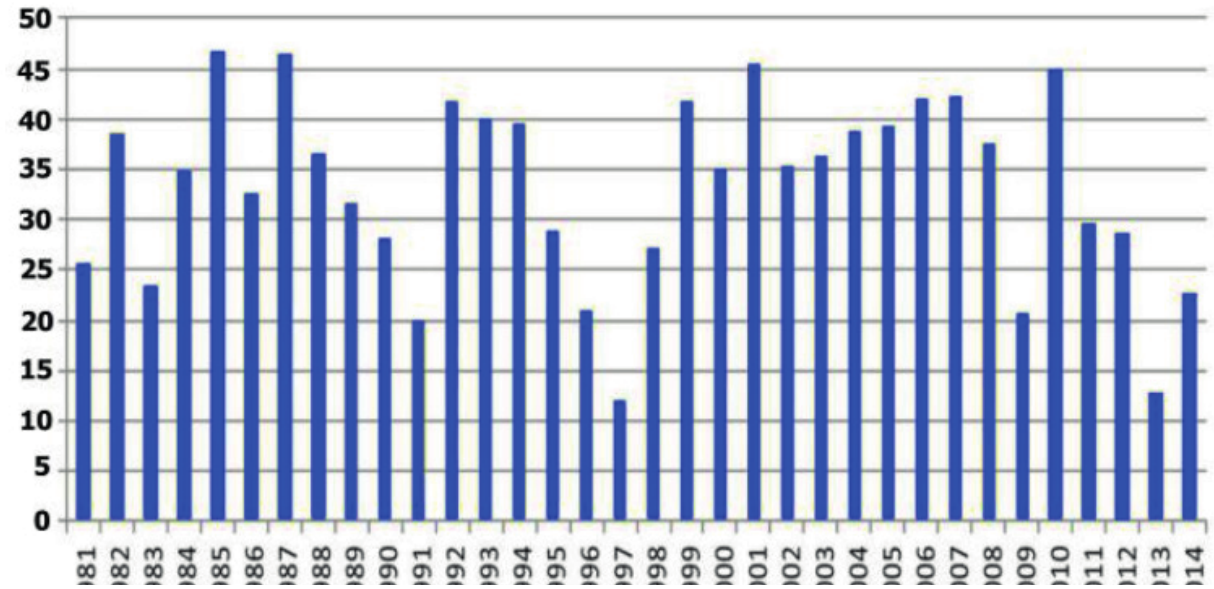
FIGURE 2 - Percentage of natural products (semi- or totally synthetic) approved over the years 1981-2014 [(Newman DJ, Cragg GM. J. Nat. Prod . 2016; 79(3)].